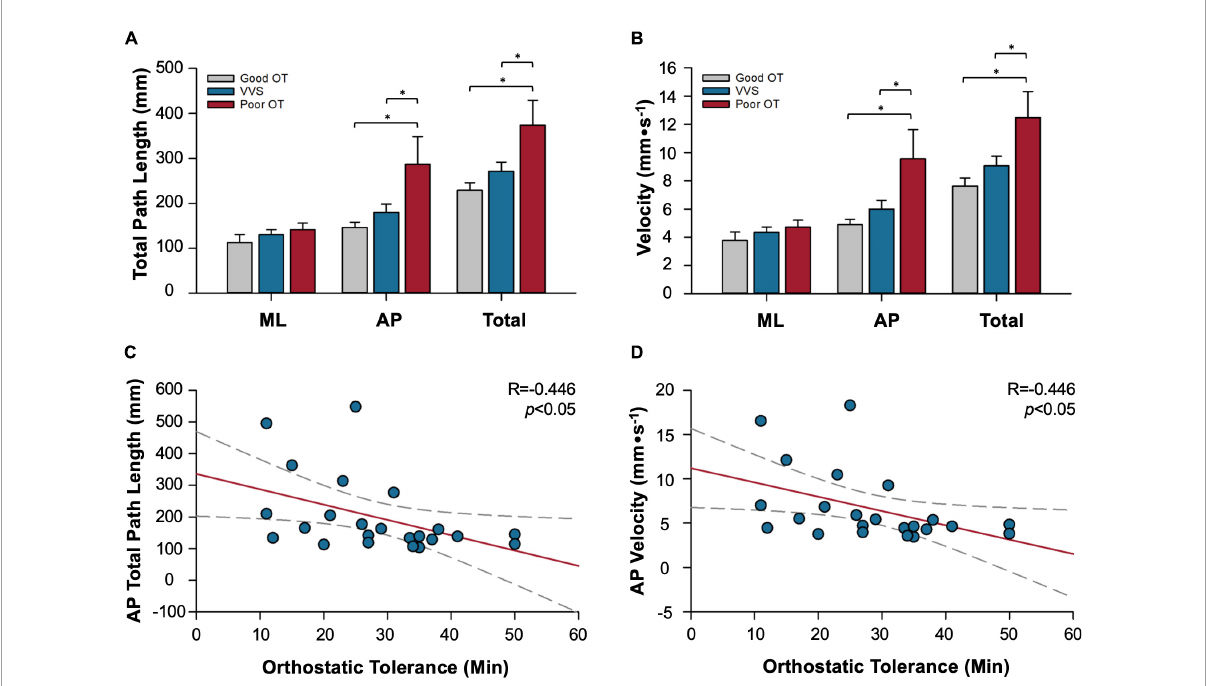
FIGURE7 Relationships between postural sway and susceptibility to syncope. Data summarize relationships between postural sway behavior (measured as total path length or sway velocity), and cardiovascular control (measured as orthostatic tolerance, OT, time to presyncope in minutes during standard head upright tilt test with lower body negative pressure). Participant groups studied: patients with vasovagal syncope (VVS), healthy participants with good orthostatic tolerance (good OT), healthy participants with poor orthostatic tolerance (poor OT). Significant increases in the distance (A) and velocity (B) of postural sway are observed during quiet standing in individuals with poor OT who do not experience syncope in daily life, particularly in the AP direction. In patients with VVS, there is no such enhancement of postural sway to compensate for their orthostatic intolerance. The distance (C) and velocity (D) moved in the AP direction was significantly correlated with OT, where those with the lowest OT had greater postural sway. *Denotes significant difference where p < 0.05. ML, mediolateral component of sway; AP, anteroposterior component of sway. Adapted from Claydon and Hainsworth 2005 (111), and Claydon and Hainsworth (110).